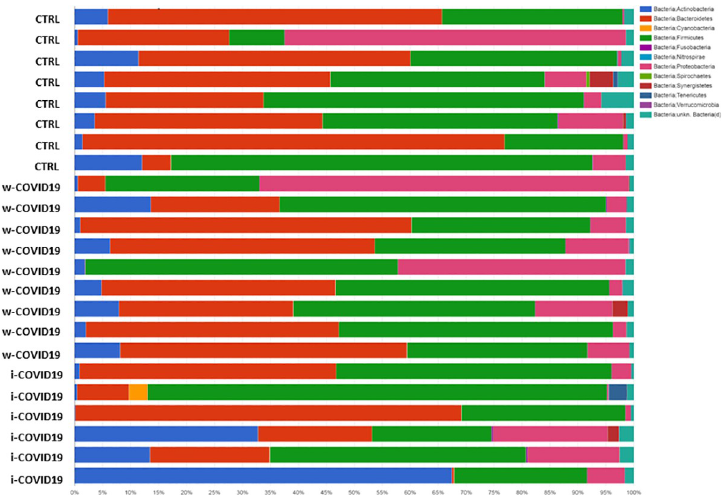
Fig 6. Taxonomy bar plot showing the individual microbiota profile at family